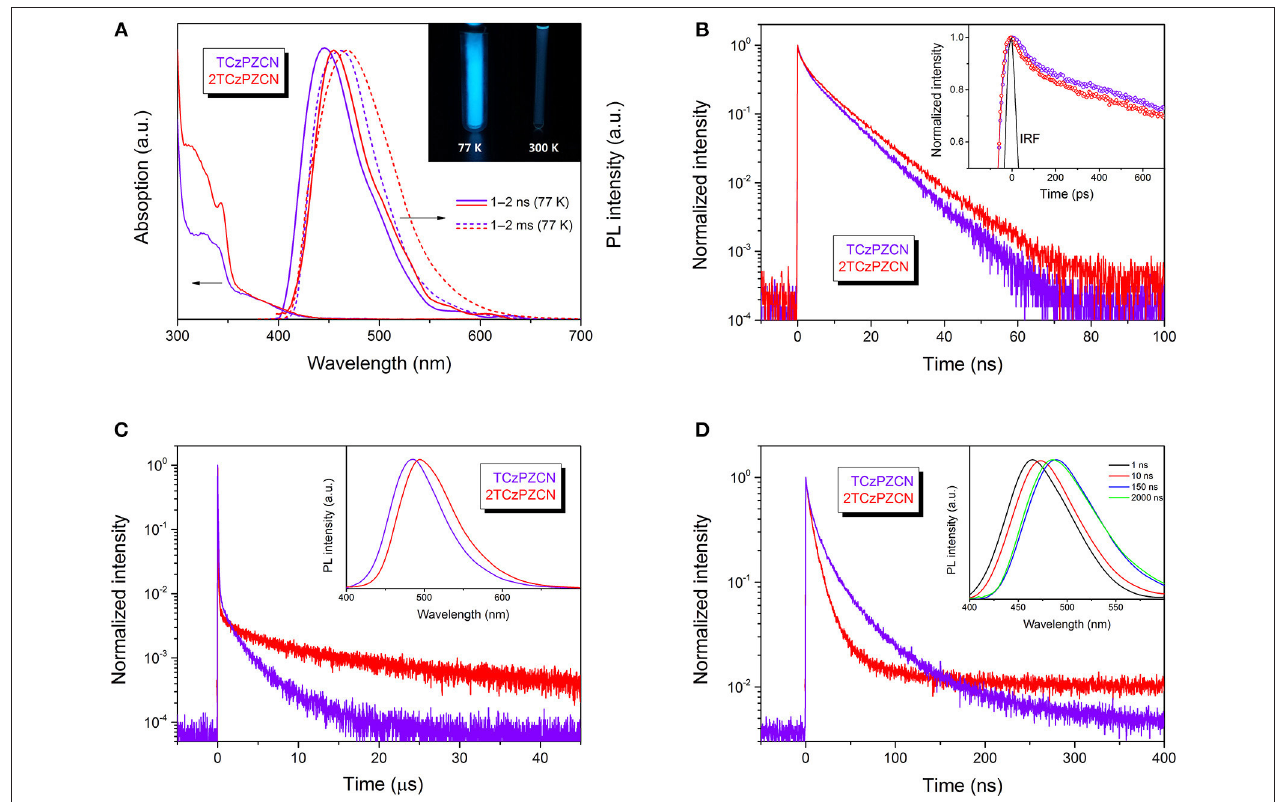
FIGURE 3 | Absorption, emission and transient decay spectra. (A) Absorption spectra of the investigated molecules in toluene at room temperature (RT), and fluorescence (1–2 ns) and phosphorescence (1–2ms) spectra in toluene at 77K. Inset: A comparison of TCzPZCN in toluene at 77K and RT under 365-nm ultraviolet irradiation. (B) Transient decay spectra of the investigated molecules in toluene at RT. Inset: Instrument response function (IRF). (C) Transient decay spectra of the investigated molecules doped into mCP films (10 wt%) measured on a microsecond time scale at RT. Inset: Steady-state emission spectra of the doped films at RT. (D) Transient decay spectra of the investigated molecules doped into mCP films (10 wt%) measured on a nanosecond time scale at RT. Inset: Time-resolved emission spectroscopy of the TCzPZCN doped films at RT.